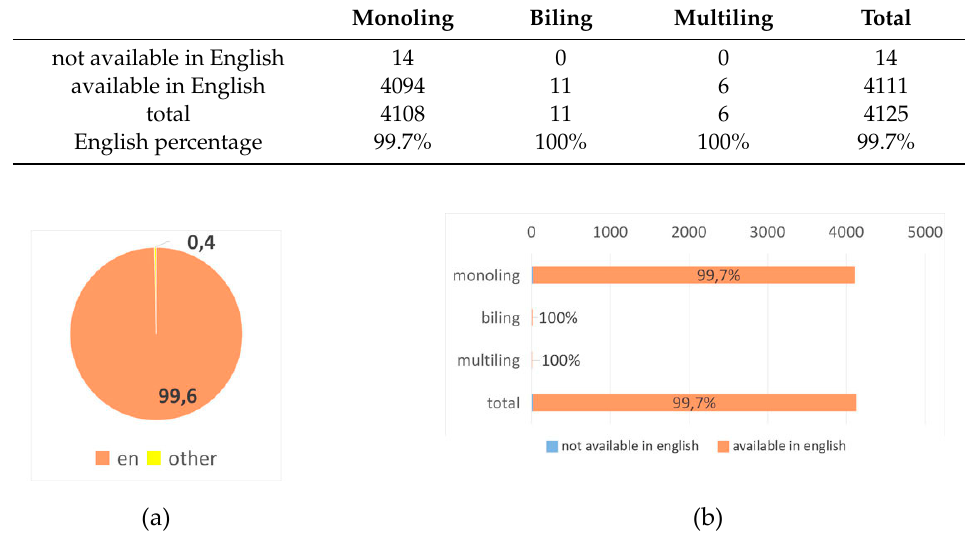
Figure A28. Visualization of the results for domain uk. ( a ) Primary languages pie chart and ( b ) English